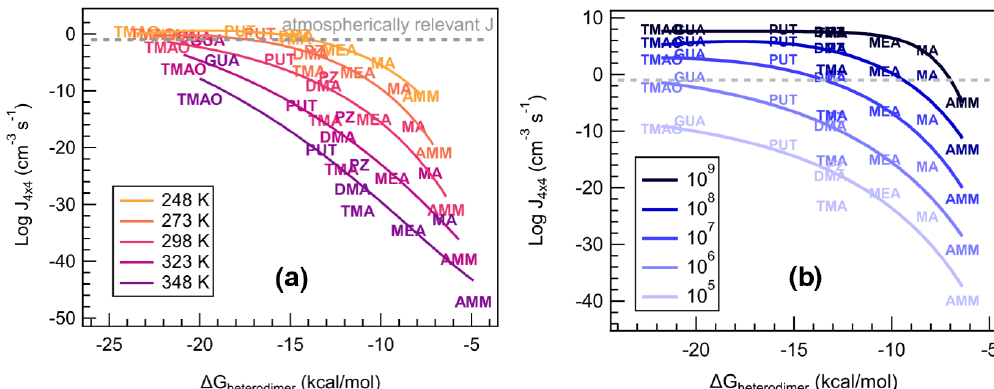
Figure 8. Heterodimer stability ( (cid:49)G heterodimer ) plotted against NPF rate (J theory ) in varied conditions. (a) Vapor concentrations are constant: [acid] = [base] = 10 6 moleccm − 3 at varying temperature: T = 248, 273, 298, 323 and 348K. (b) Temperature is constant: T = 298K at varying vapor concentrations: [acid] = [base] = 10 5 , 10 6 , 10 7 , 10 8 and 10 9 moleccm − 3 . Text markers are centered over the data point.